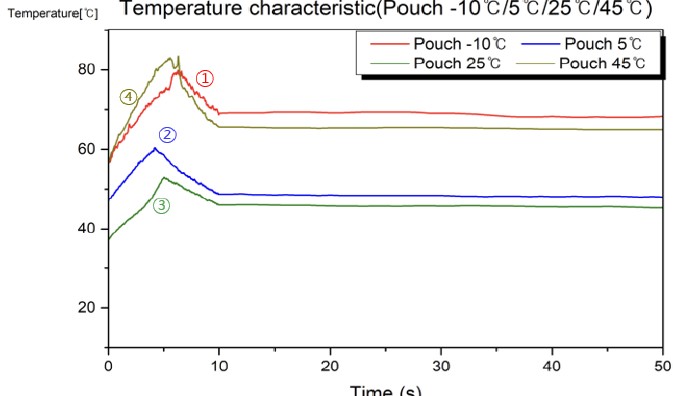
Figure 14. Temperature status of pouch cell during testing according to preprocessing tempera- ture.